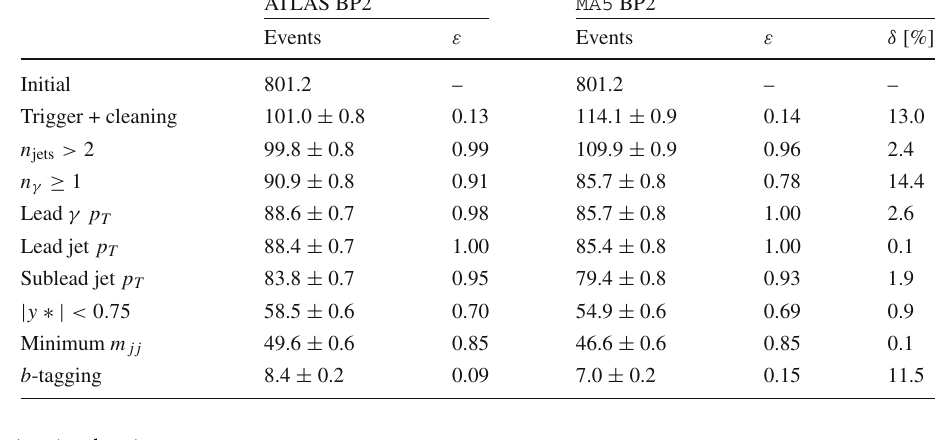
Table 6 Search for a di-jet resonance produced in association with a photon: cut flows for BP1 comparing the MA5 event analysis as described in Sect. 3.3 and the numbers provided by ATLAS. For BP2, the combined trigger is employed